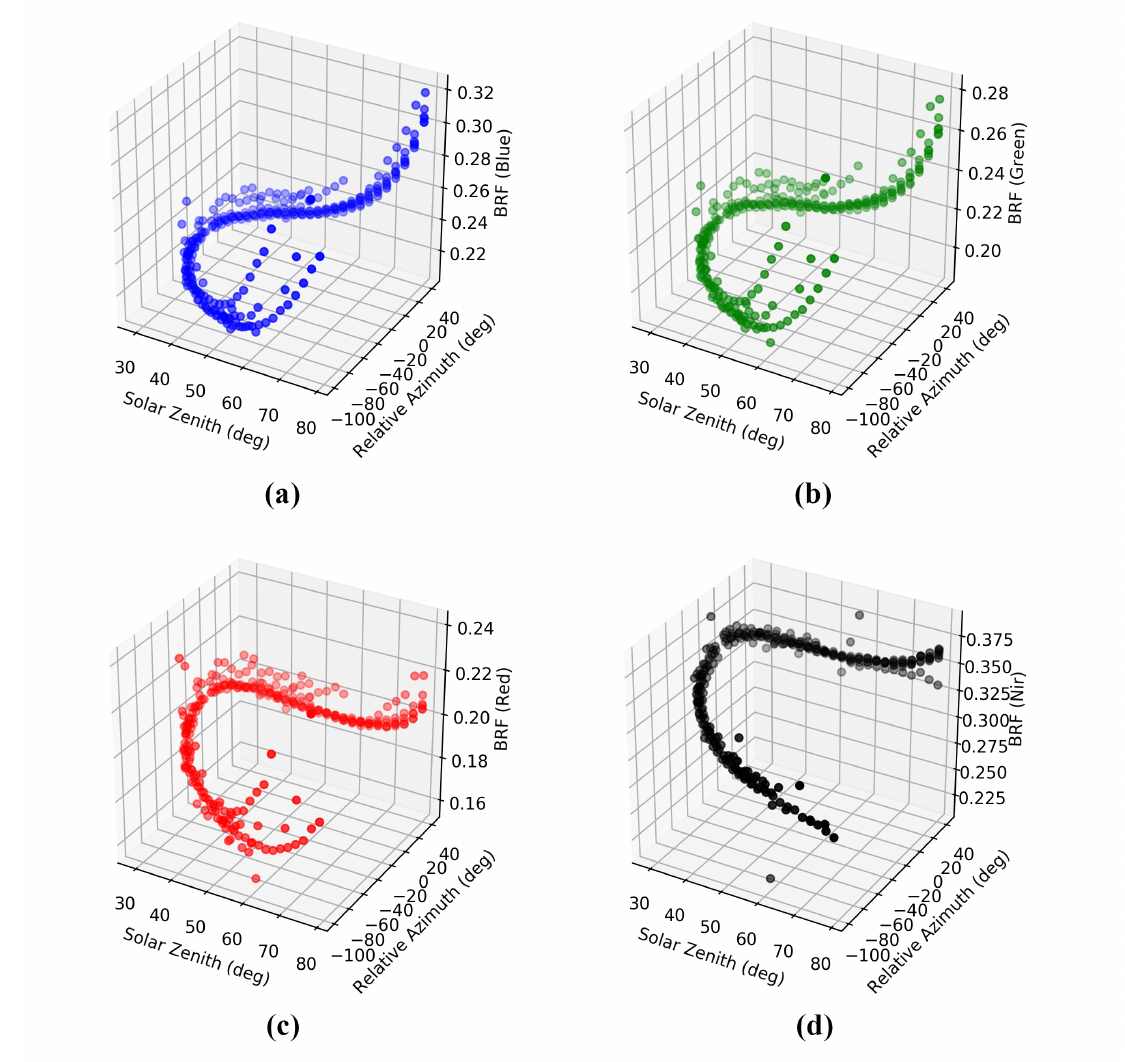
Figure 11. TOA BRFs of the first four bands of Himawari-8 AHI as functions of solar zenith and the relative azimuth angles in a 3D Cartesian coordinate system: ( a ) Band 1 (0.47 µ m), ( b ) Band 2 (0.51 µ m), ( c ) Band 3 (0.64 µ m), and ( d ) Band 4 (0.86 µ m). Data are compiled over a vegetated pixel located at (13.29 ◦ S, 132.65 ◦ E) in Kakadu National Park, Australia, from 1 May 2018 to 8 May 2018. Only BRF values with clear-sky and low-aerosol conditions are included in the example. The satellite view zenith and azimuth angles of the site are 17.8 ◦ and 29.4 ◦ , respectively. Solar relative azimuth angles are calculated as the difference between the solar and the satellite azimuth angles. Positive or negative relative azimuth angles indicate that the Sun is on the east or the west to the satellite,